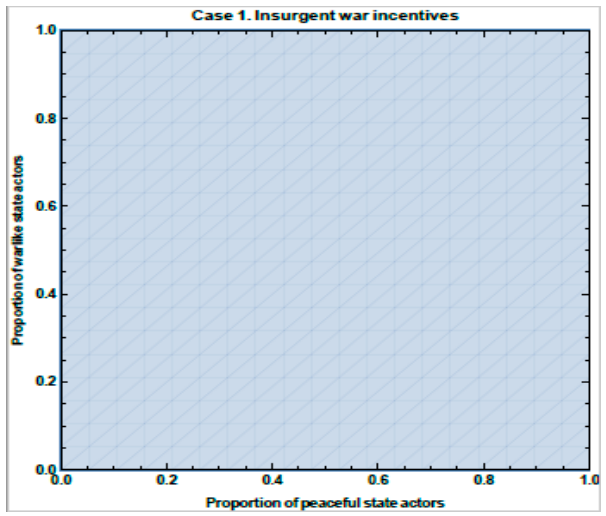
Figure 1. Fitness for Insurgents when for r = 0.3, δ = 0.1, c = 0.2, and p = 0.5.